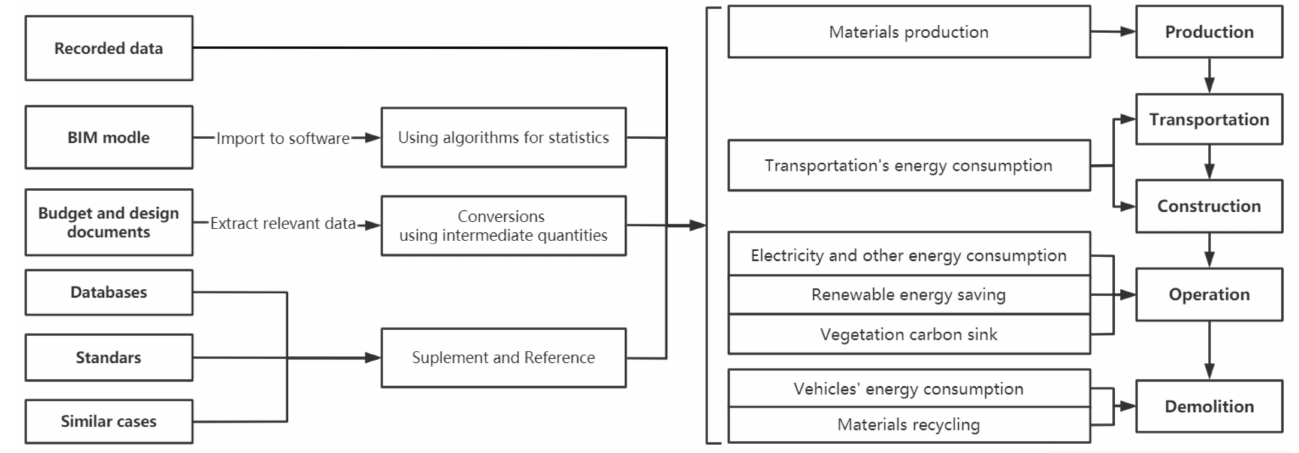
Figure 1. Frame of building whole life cycle carbon emission calculation